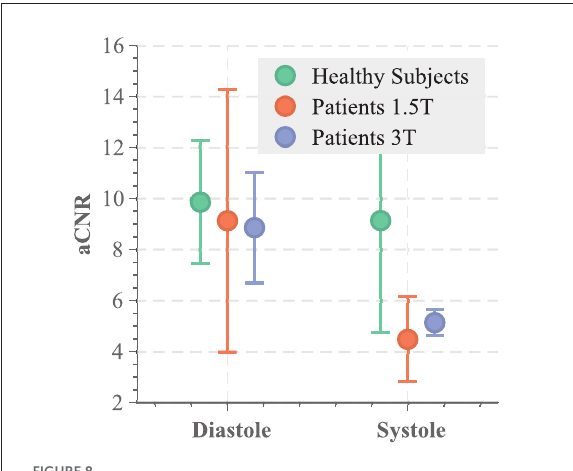
FIGURE8 aCNR across the different cohorts, analyzed for a diastolic and systolic phase of the functional LGE